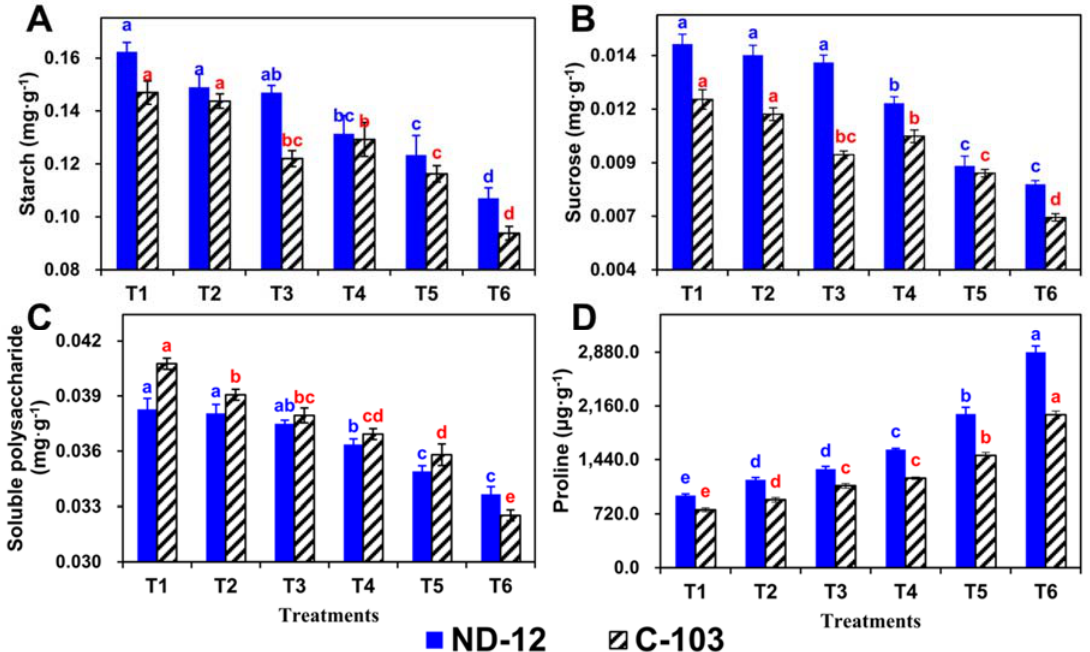
Figure 5. Effect of split-root water imbalance treatments on osmoprotectant of two soybean genotypes ND12 (drought resistant) and C103 (drought susceptible). ( A ) Starch mg · g − 1 , ( B ) sucrose mg · g − 1 , ( C ) soluble polysaccharide mg · g − 1 , ( D ) proline µ g · g − 1 . (Means ± SE), same small letters are not significantly different at p < 0.05. T1, 100/100; T2, 100/50; T3, 100/20; T4, 50/50; T5, 50/20; T6, 20/20.